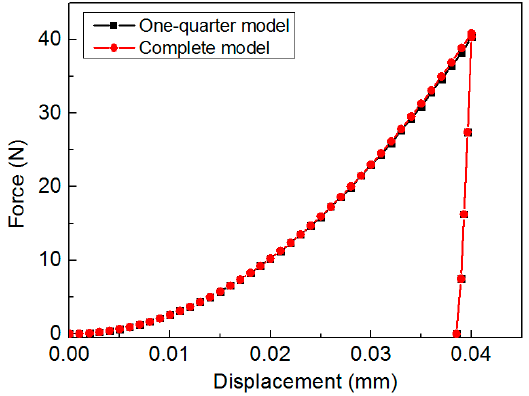
Figure 3. Convergence and effectiveness tests of the one-quarter finite element (FE) model.